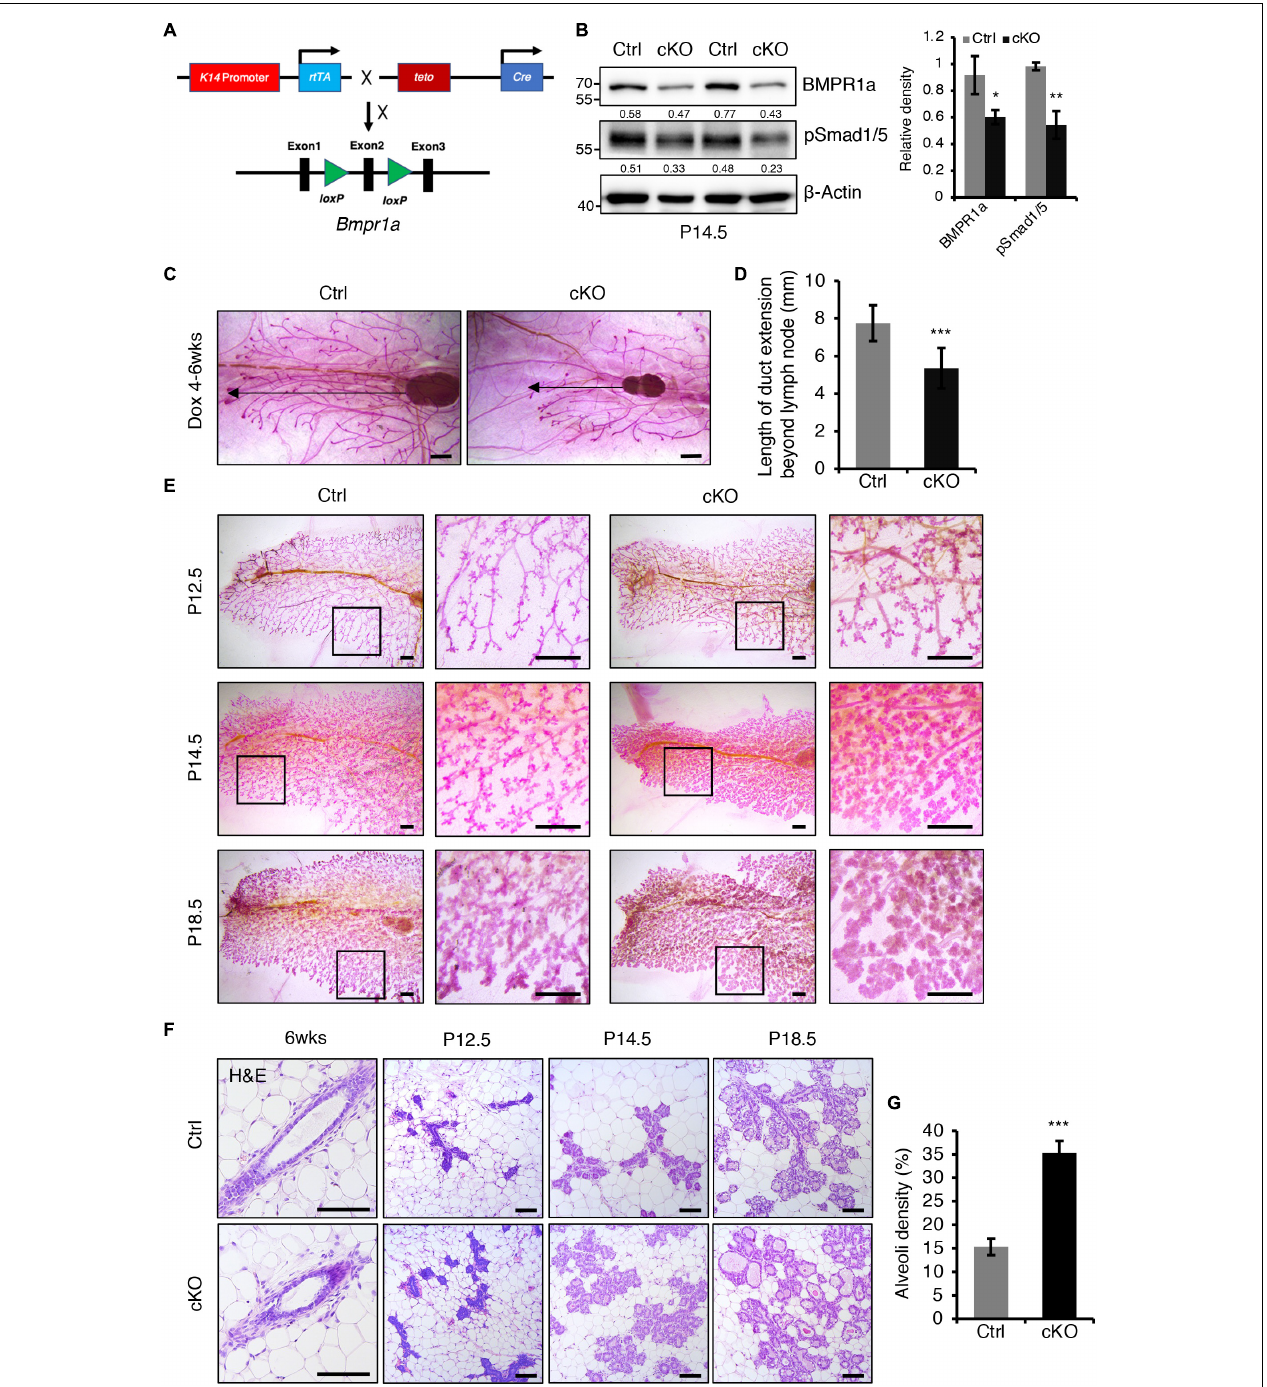
FIGURE 2 | BMPR1a deficiency resulted in enlarged alveoli during pregnancy. (A) Schematic map of the constructs used to generate inducible mammary epithelial BMPR1a cKO mice (cKO). (B) Western blotting for BMPR1a and pSmad1/5 in mammary epithelial cells isolated from control (Ctrl) and cKO mice at pregnancy day 14.5 (P14.5). β -Actin was used as a loading control. Statistical analysis the expression of BMPR1a/ β -Actin and pSmad1/5/ β -Actin. n = 3 mice. (C,D) Whole-mount staining of mammary glands from control and cKO mice at 6 weeks of age. The mice were treated with Dox from 4 weeks of age. Quantification of duct length beyond the lymph node. n ≥ 5 biological replicates. Scale bar, 1 mm. (E) Whole-mount staining of mammary glands from control and cKO mice at pregnancy day 12.5 (P12.5) ( n = 3 per group), pregnancy day 14.5 (P14.5) ( n = 4 per group) and pregnancy day 18.5 (P18.5) ( n = 3 per group). High-magnification areas are shown in black boxes. Scale bar, 1 mm. (F) Hematoxylin and eosin staining of mammary glands at the indicated time points (P12.5, pregnancy day 12.5; P14.5, pregnancy day 14.5; P18.5, pregnancy day 18.5). n = 3 mice per time point. Scale bar, 100 µ m. (G) Quantitation of alveoli density in control and cKO mice HE-stained mammary gland sections at pregnancy day 14.5. n = 3 mice per group. Data were presented as means ± SD. ∗ p < 0.05, ∗∗ p < 0.01, ∗∗∗ p < 0.001.